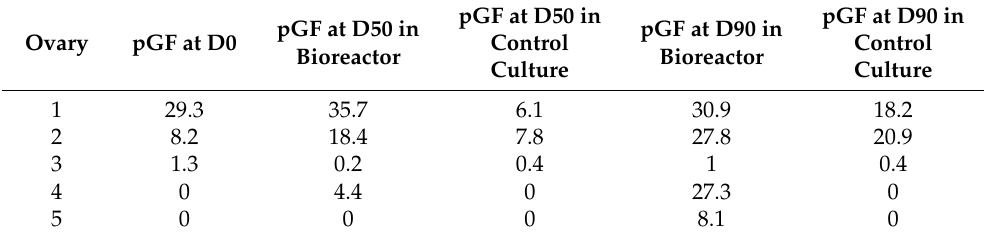
Table 2. Percentages of growing follicles (pGF) relative to all follicles present according to the culture time and type.